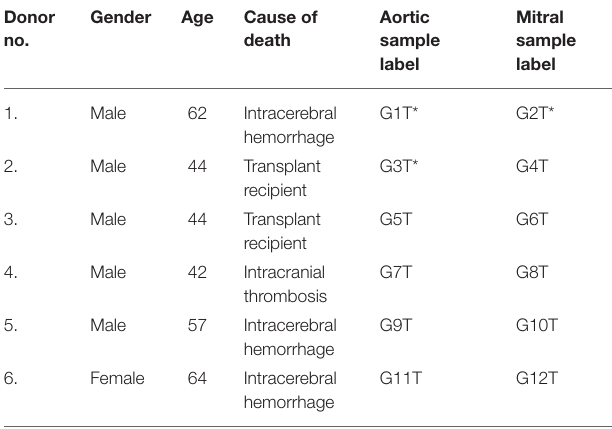
TABLE 1 | Cohort demographic and clinical